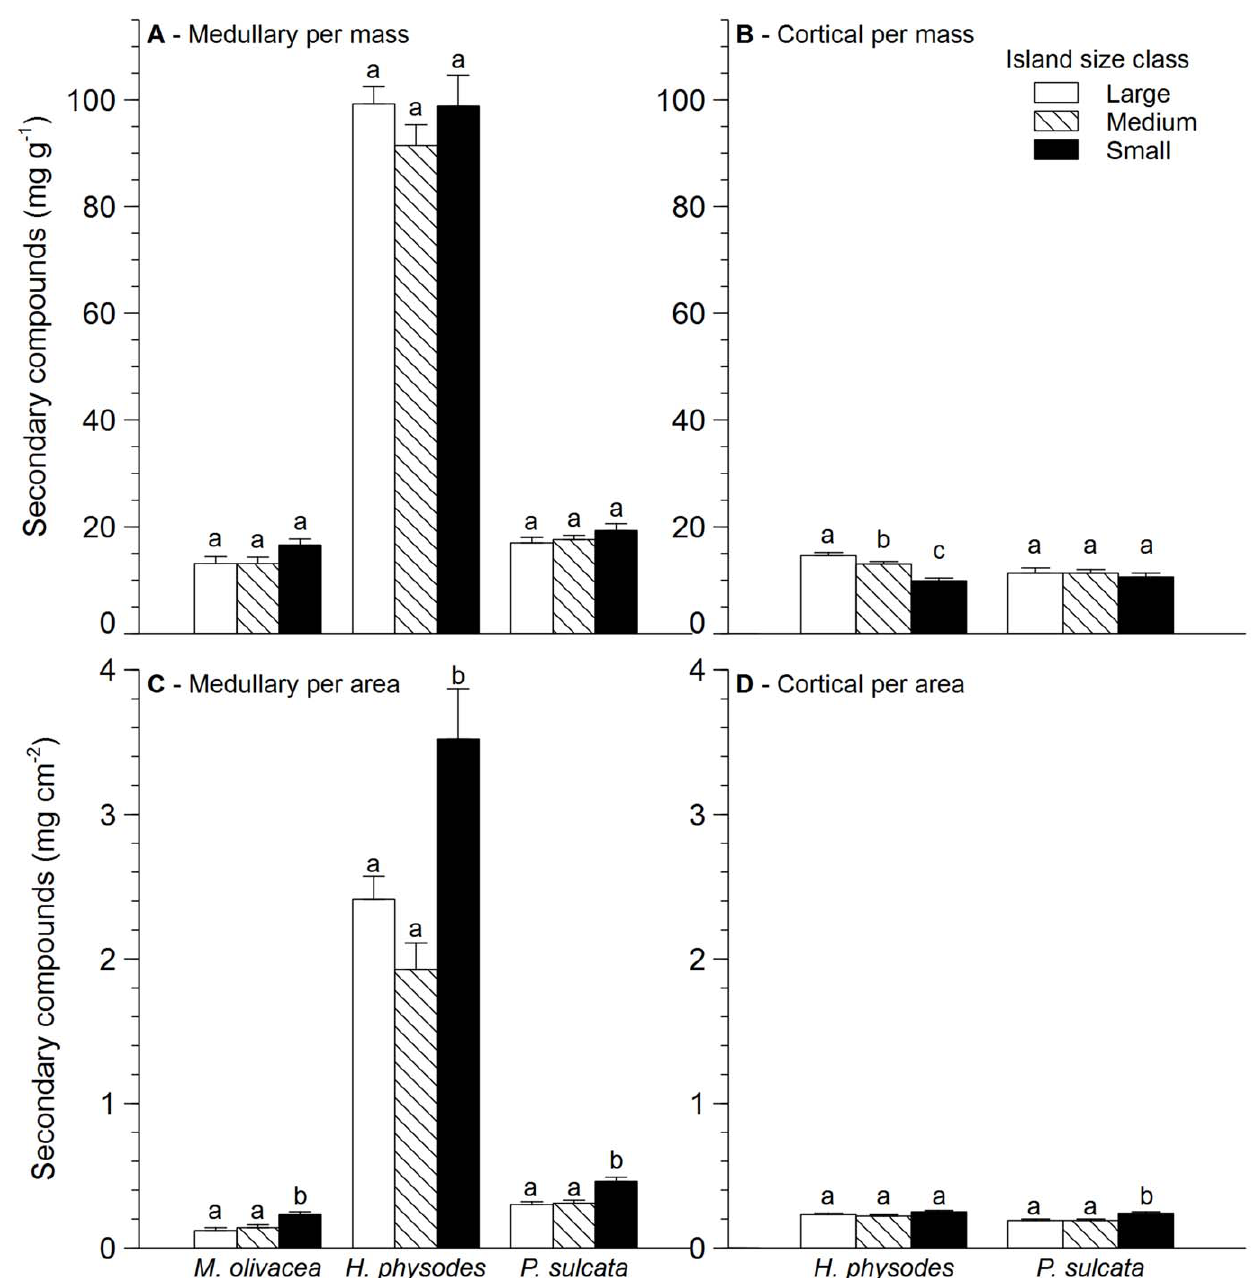
Figure 2. Response of lichen secondary compounds to island size. Values are given for concentrations (mean + SE) of medullary (A and C) and cortical (B and D) carbon based secondary compounds expressed per thallus mass (A–B) as well as per thallus area (C–D) in three lichen species across three island size classes. Melanohalea olivacea lacks cortical compounds and is therefore not included in panels B and D. Letters within species distinguish significant differences ( P , 0.05, Tukey’s post hoc test) between island size